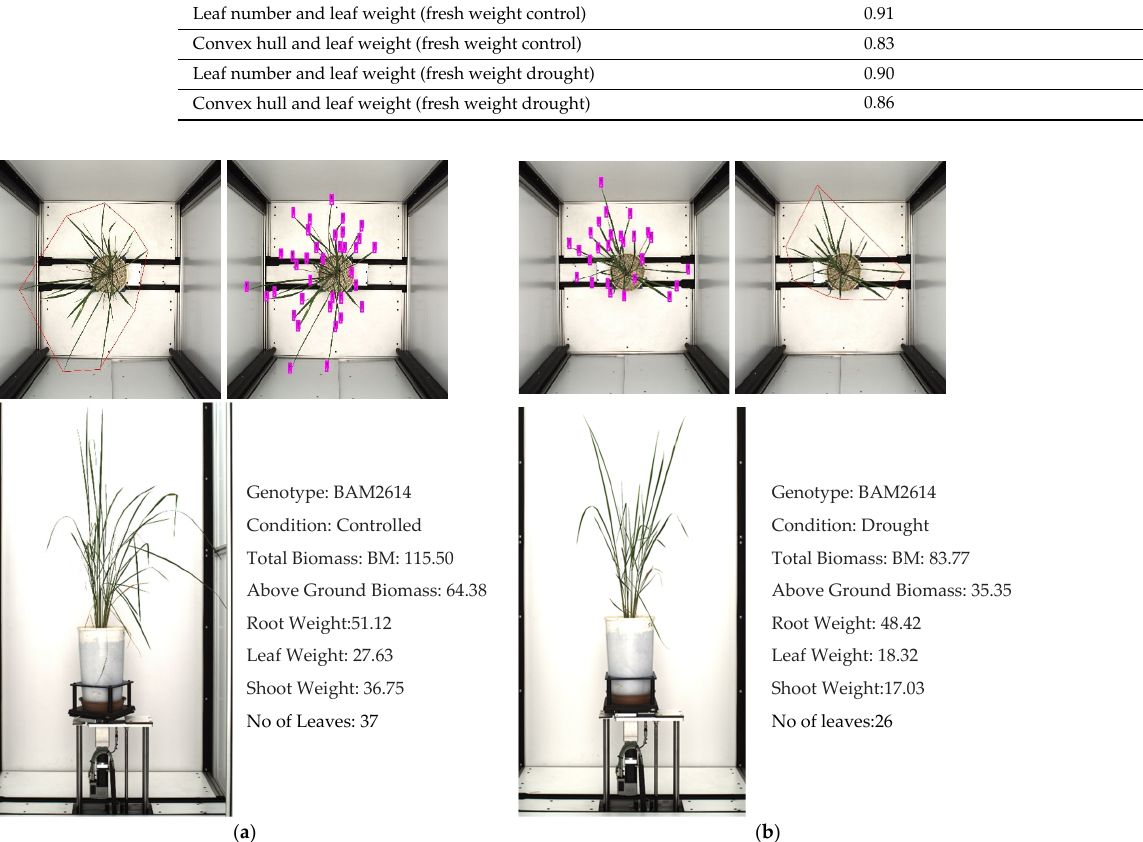
Table 3. Correlation analysis between quantitative traits and image traits. Traits Correlation